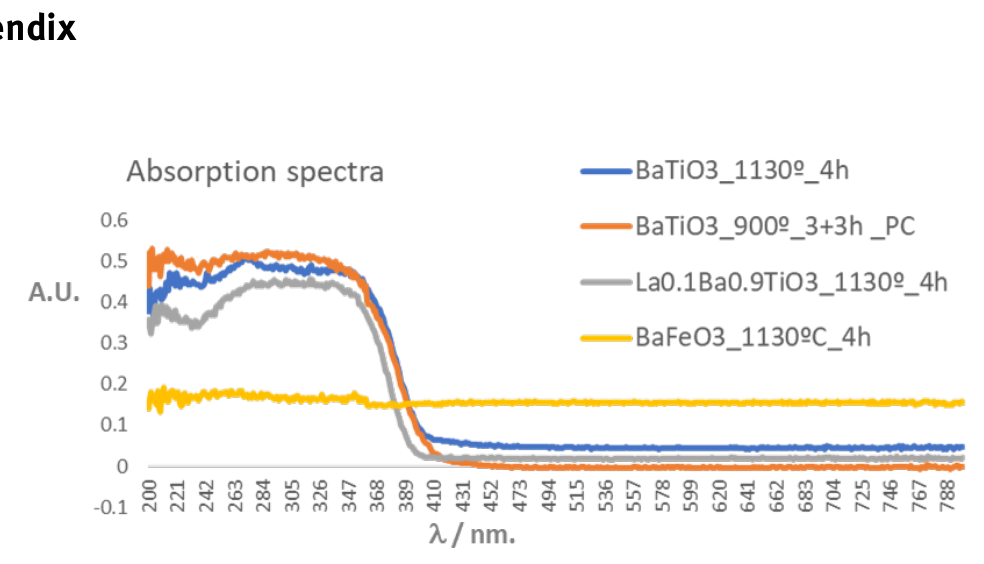
Figure S1: UV-Visible absorption spectra of the perovskite